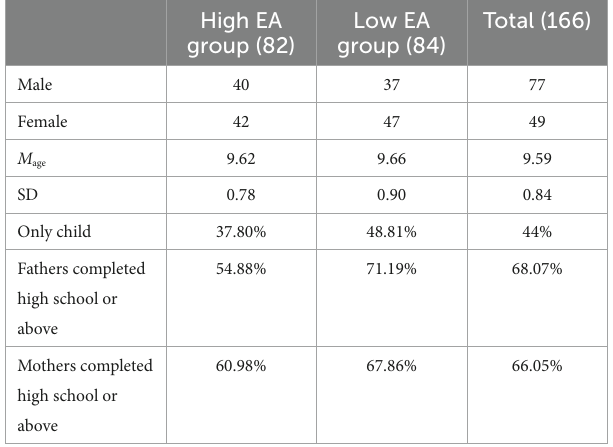
TABLE 1 The demographic variables of the participants in the two